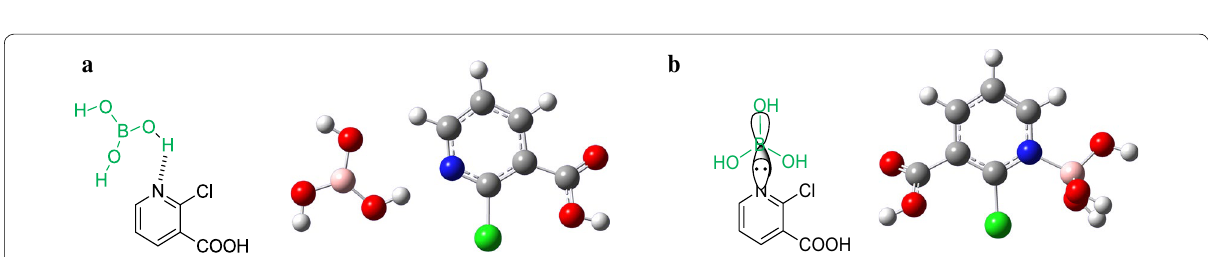
Fig. 3 Two possible pathway for catalytic activation of 2-chloronicotic acid with Boric acid. a HBD, b Boron-Nitrogen Lewis acid–base